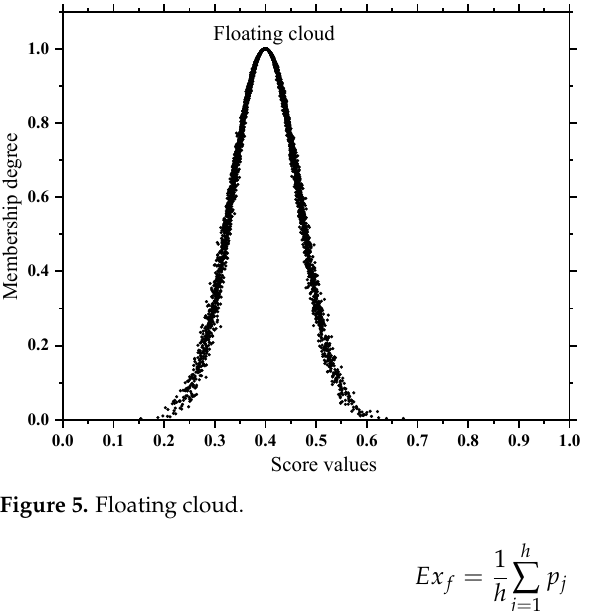
Figure 5. Floating Figure 5. Floating cloud.